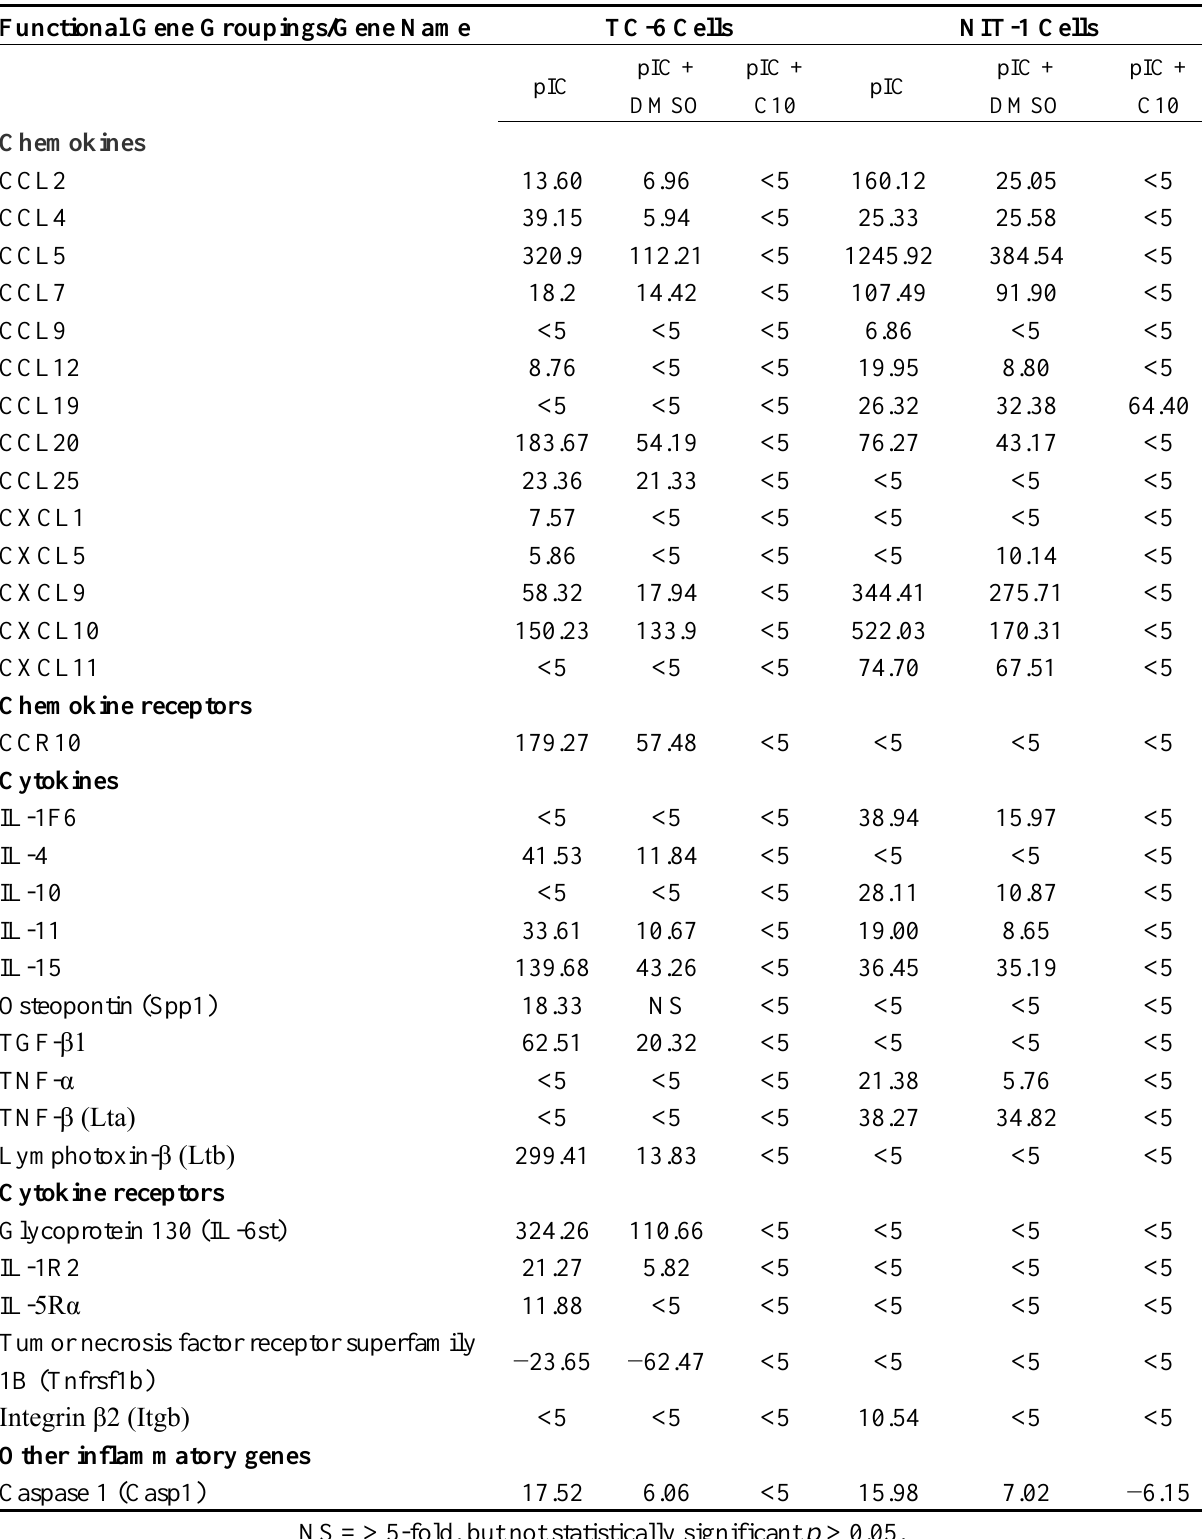
Table 3. Relative fold changes induced by pIC and inhibition by C10 on expression of inflammatory cytokine gene